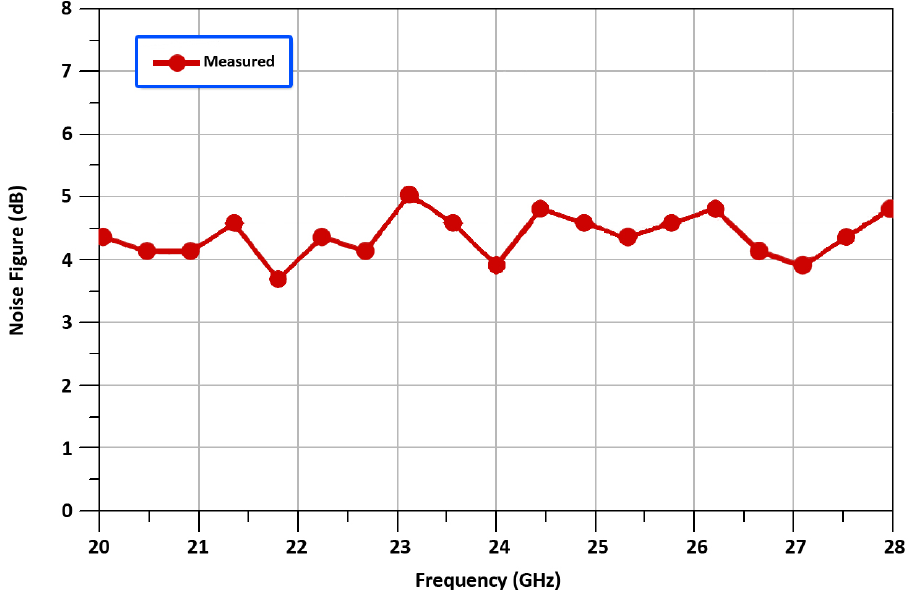
Figure 16. Measured noise fig. vs. RF frequency.